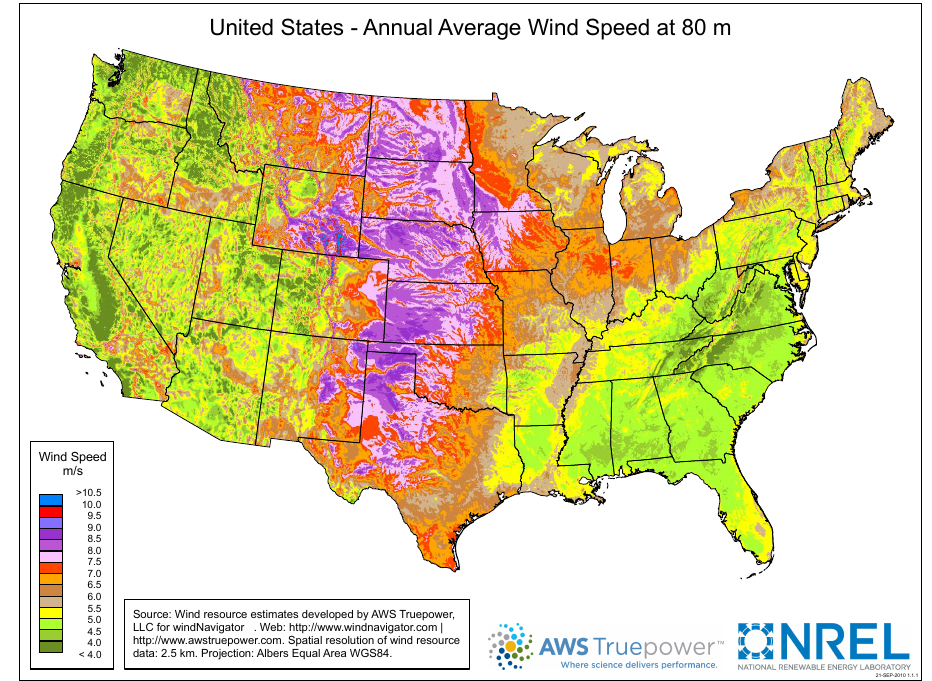
Fig. 9b. US wind map at 80m developed by